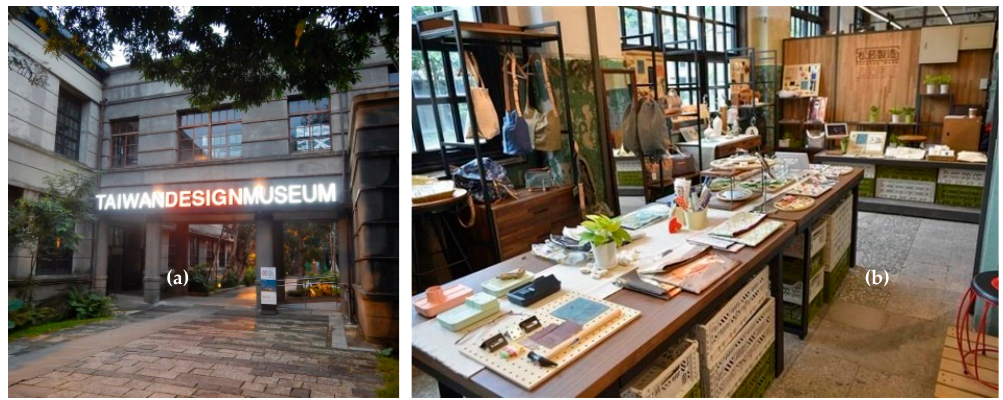
Figure 6. ( a ) Taiwan Design Museum. ( b ) Songyan Style Gallery Creative Cluster [30].